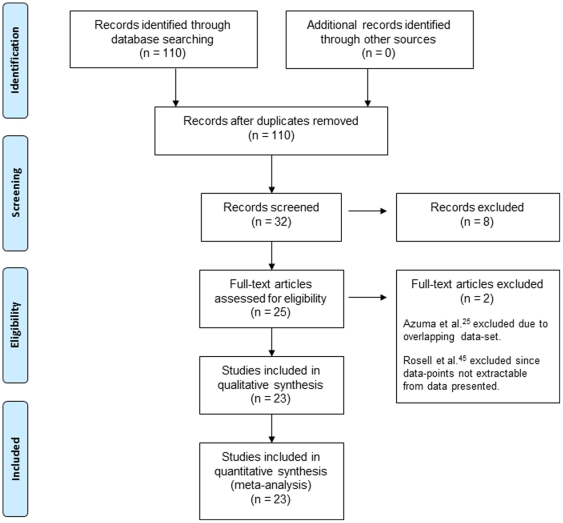
PRISMA10 flow chart of selection process to identify studies eligible for pooling.